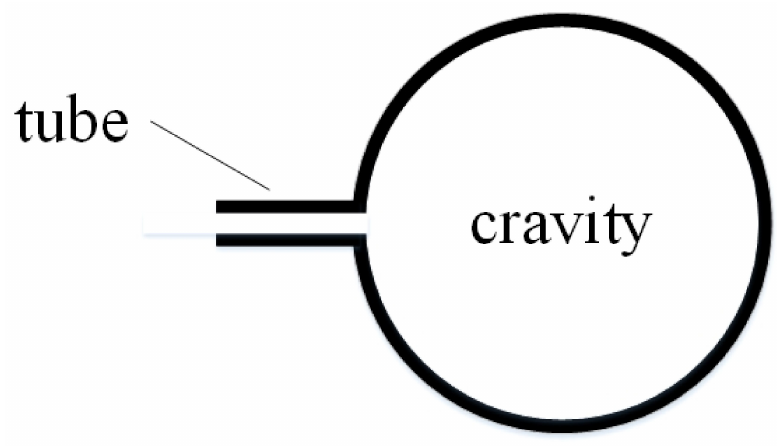
Figure 1. Helmholtz